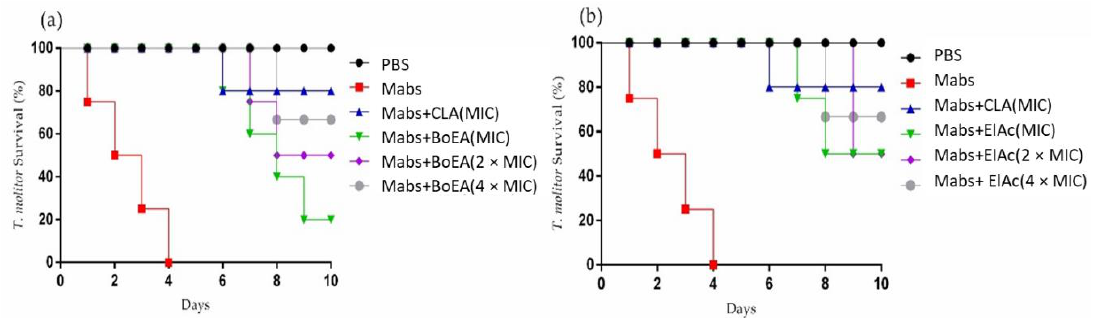
Figure 5. Effects of BoEA and ElAc on the T. molitor survival after lethal infection with Mabs . Effect of MIC, 2 × MIC, and 4 × MIC of ( a ) BoEA and ( b ) ElAc on larval survival. Ten larvae were included in each group and were monitored daily to assess mortality. PBS-treated group represents the negative control, while the clarithromycin-treated group represent the positive control. The results are representative of one of three independent experiments. Abbreviations: PBS, phosphate-buffered saline; CLA, clarithromycin; MIC, minimum inhibitory concentration; BoEA, ethyl acetate fraction of B. orellana ; ElAc, ellagic